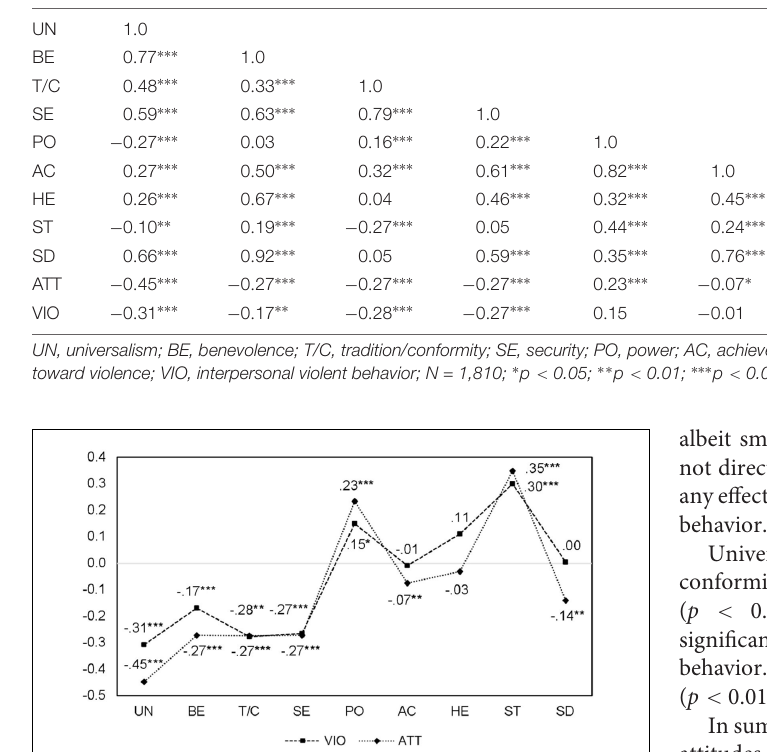
TABLE 3 | Correlations between values, attitudes toward interpersonal violence, and interpersonal violent behavior. UN BE T/C SE PO AC HE ST SD ATT VIO